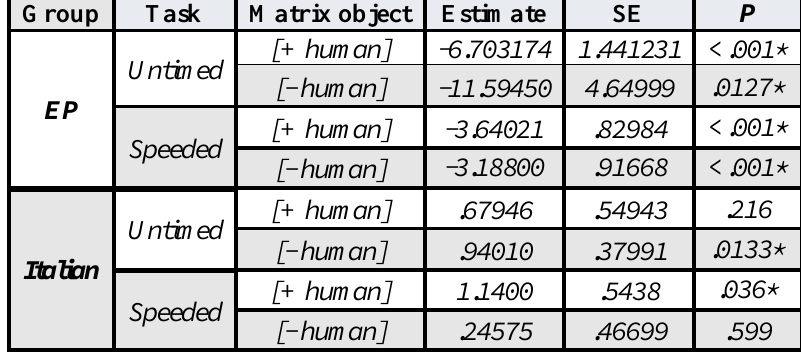
Table 5. Difference between subject and object antecedent assignment in null pronoun